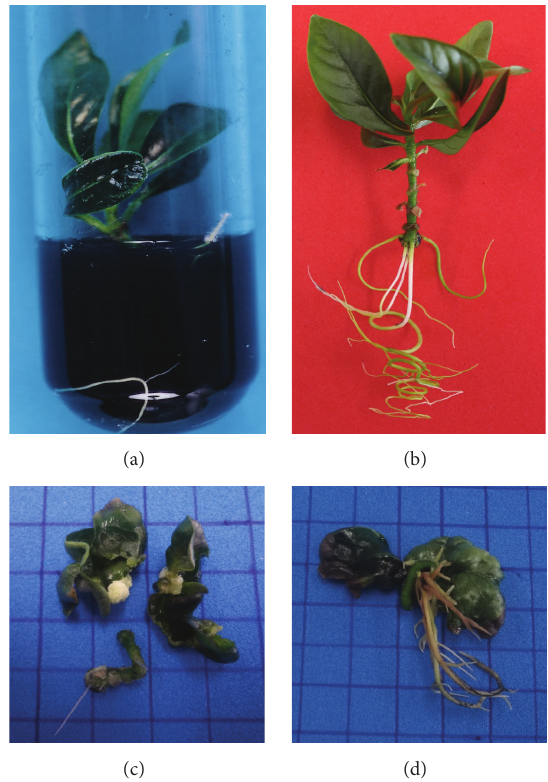
Figure 4: Seedlings obtained from G. americana L. embryonic axes after 30 days of growth in vitro . Normal seedlings obtained from embryonic axis that was desiccated to approximately 13% of the initial mc (a) or embryonic axis that was desiccated and cryopreserved in liquid nitrogen (b). Abnormal seedlings showing desiccation damage to the root system (c) and freezing damage to the apical meristem